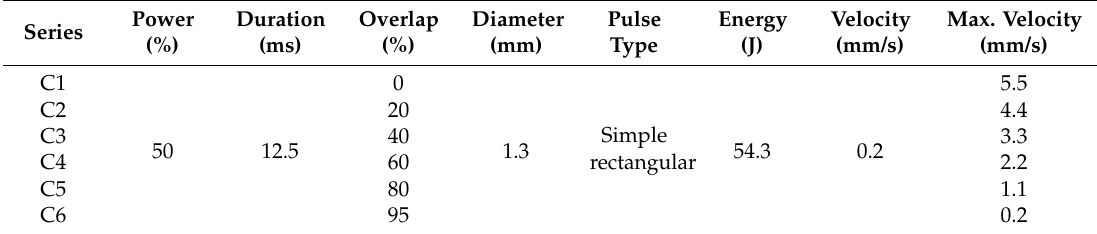
Table A4. Experimental plan for the effects of spot laser diameter on weld penetration.